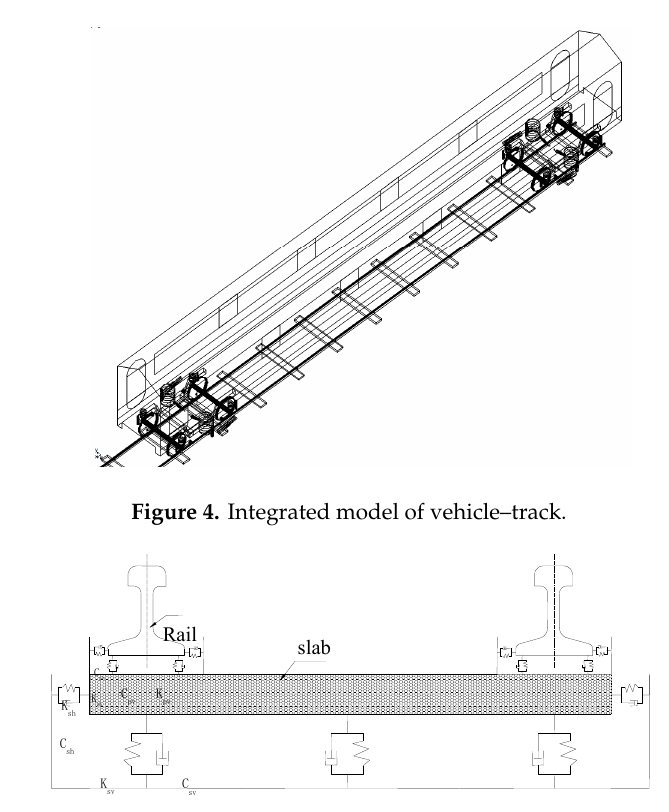
Figure 5. Integrated model of slab track with flexible foundation.